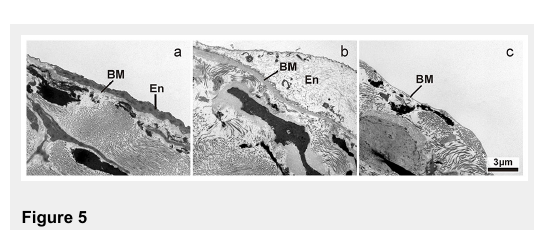
Transmission electron microscopic image of endothelial damage on vessel wall surface near a valves surface with increasing severity from a to c: a) normal endothelial cells; b) drastically swollen and necrotic appearance of the endothelial cells, basal membrane is also swollen; c) denuded vessel wall surface with absent endothelial cells showing direct contact of the basal membrane with the vessel lumen. En: endothelial cells, BM: basal membrane. Magnification: